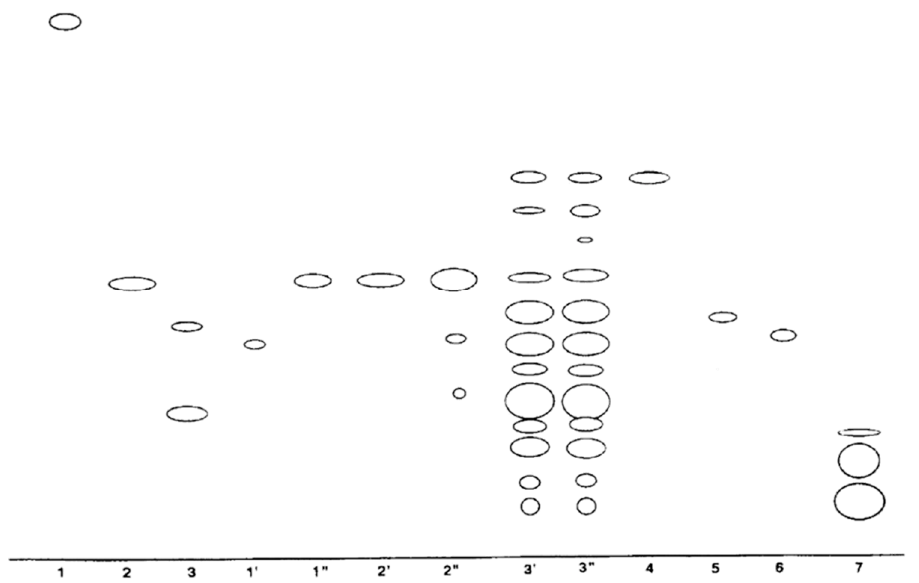
Figure 6. Thin-layer chromatography of crude extracts from alfalfa leaves, stems, and roots under UV light. 1: Medicagenic acid; 2: Soyasaponin 1; 3: 3-Glc-Glc, 28 AraRhaXyl medicagenic acid; 1 ′ and 1”: Stem samples; 2 ′ and 2”: Leaf samples; 3 ′ and 3”: Root samples; 4: 3-Glc, 28-Glc medicagenic acid; 5: 3-Glc, 28 AraRhaXyl medicagenic acid; 6: 3-GlcA, 28 AraRha medicagenic acid; and 7: Zanhic acid Table 6. Identification of saponins in the alfalfa leaf extracts. Saponin Concentration (ppm)